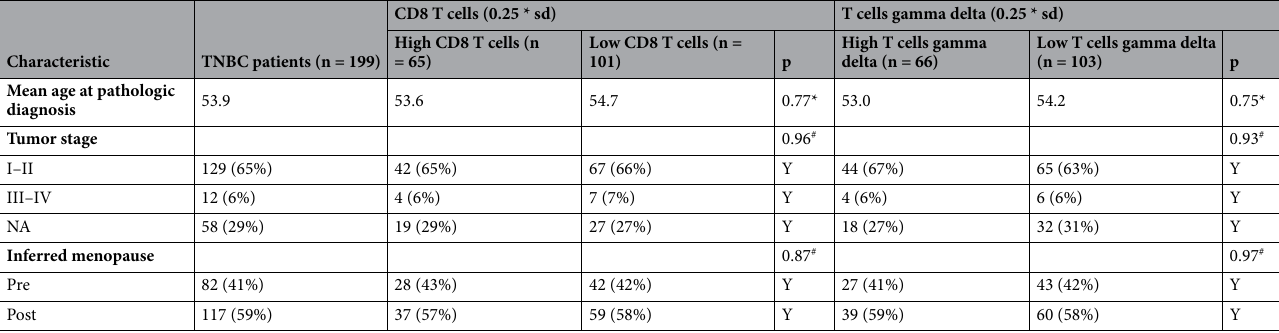
Table 4. Characteristics of METABRIC TNBC patients. METABRIC: Molecular Taxonomy of Breast Cancer International Consortium; TNBC: triple negative breast cancer; p: pvalue; sd: standard deviation; *: